Question: Looking at the figure, what chart type is it?
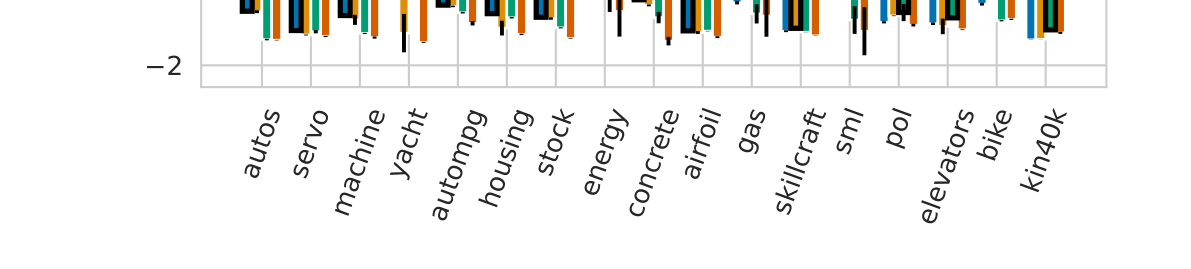
Answer: bar